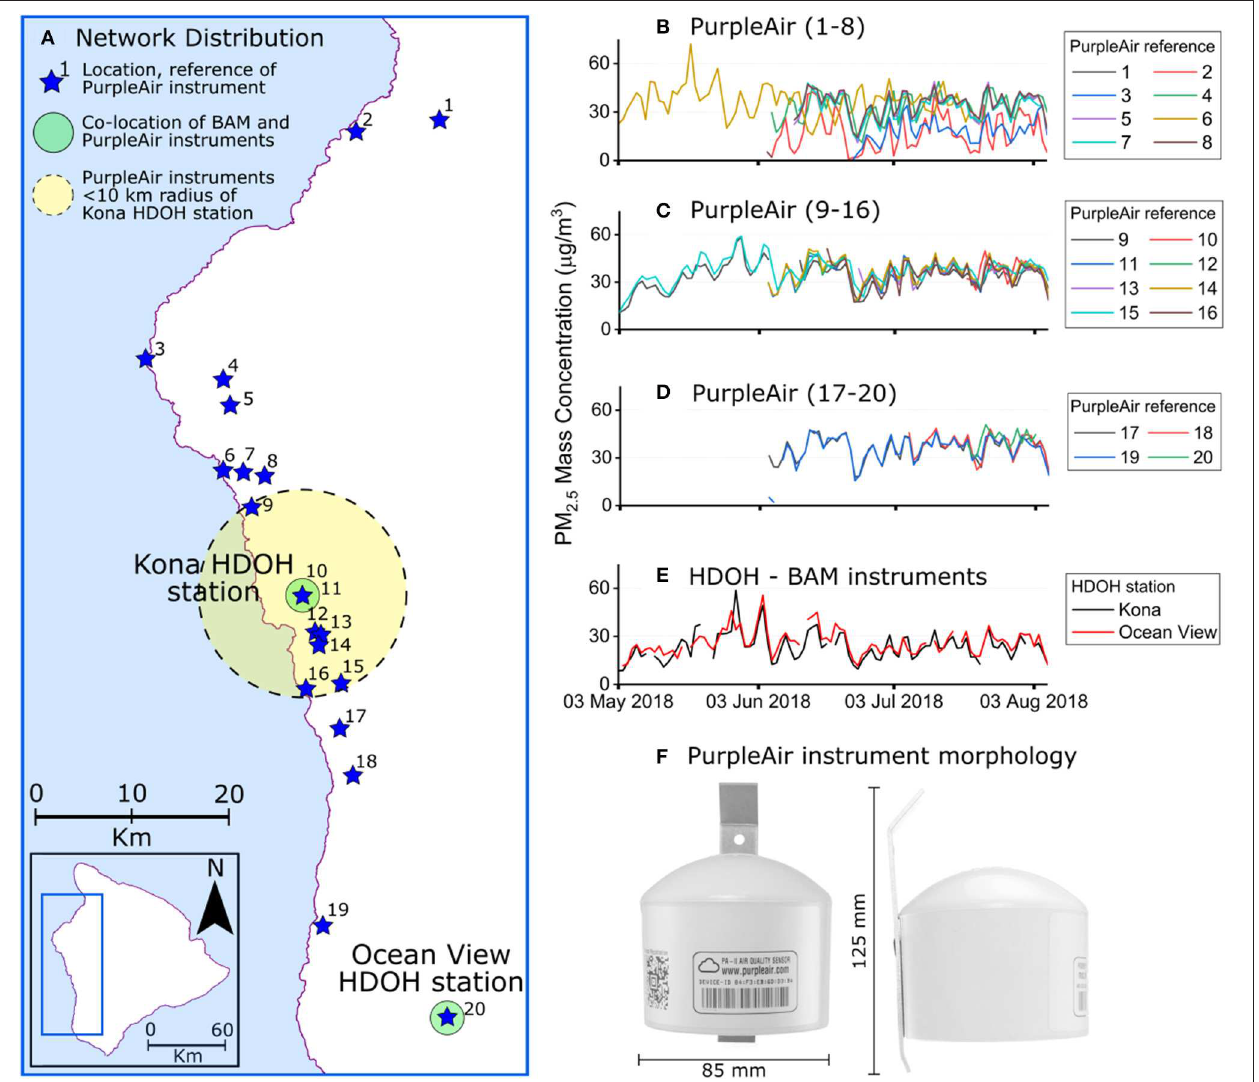
FIGURE 6 | Hawai’i Department of Health ambient air quality stations and community-operated PurpleAir instruments along the western region of the Island of Hawai’i selected for analysis in this study. (A) Distribution of publicly-owned PurpleAir instruments, indicated by blue stars with reference numbers, distribution of Kona and Ocean View HDOH stations indicated by green circles. PurpleAir instruments within 10 km radius of Kona HDOH station indicated by dashed yellow circle. (B–D) 24-h average mass concentration measurements from 20 PurpleAir instruments during the 2018 LERZ eruption; (E) 24-h average PM 2.5 from BAM instruments at Kona and Ocean View HDOH ambient air quality stations during the 2018 LERZ eruption. (F) Size and morphology of the PurpleAir instruments, seen from the front (left image) and side (right image). Photos by kind permission of PurpleAir LLC.